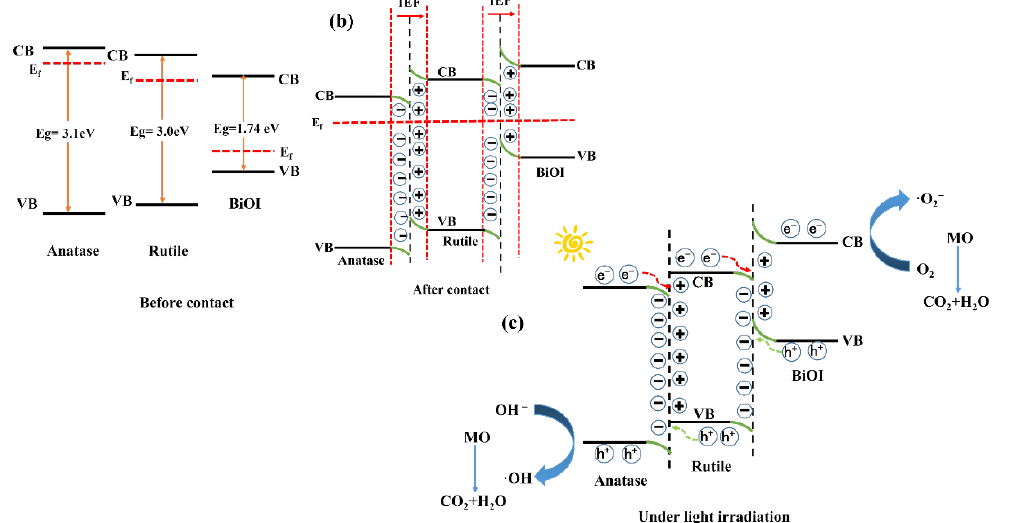
Figure 12. Charge transfer process in anatase–rutile TiO 2 /BiOI S-type heterojunction: ( a ) before contact, ( b ) after exposure, ( c ) transfer of photogenerated carriers under light irradiation.